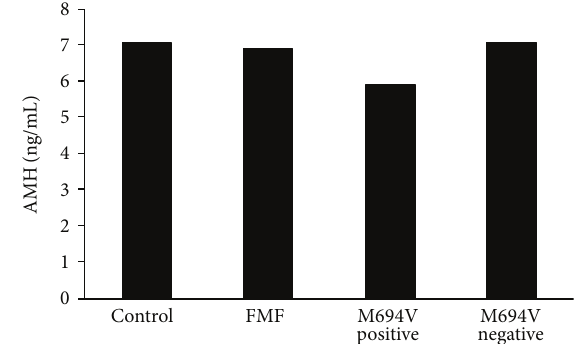
Table 3: Correlation coefficients and their significance